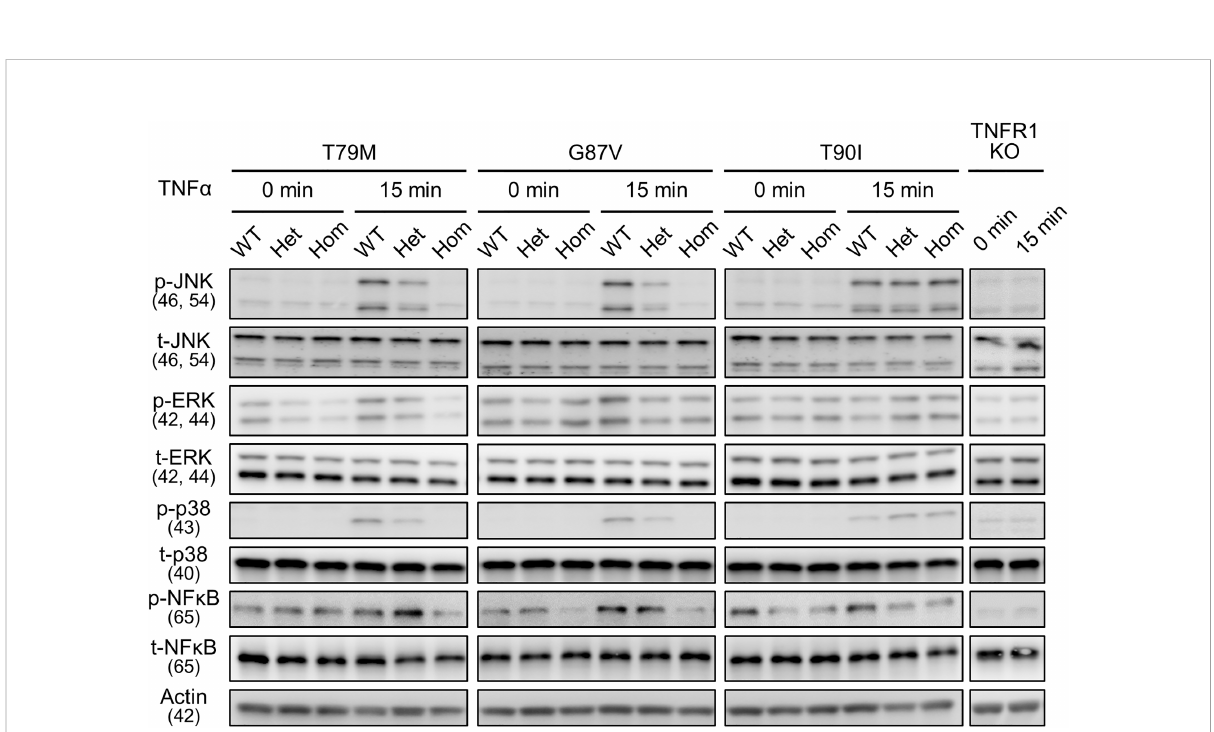
FIGURE 6 Reduced activation of MPAK and NF- k B signaling pathways in response to TNF a by the TRAPS mutations. Primary murine bone marrow-derived macrophages were stimulated with 20 ng/mL TNF a . Protein samples were collected before and 15 min after stimulation. Cell culture experiments were performed separately for each strain. Phospho- or total-JNK, ERK, p38, and NF- k B p65 levels were detected using speci fi c antibodies. Actin was used as a loading control. TNF a , Tumor necrosis factor a ; TRAPS, TNF receptor-associated periodic syndrome; NF- k B, nuclear factor- k B; WT, wild-type; Het, heterozygote; Hom, homozygote.